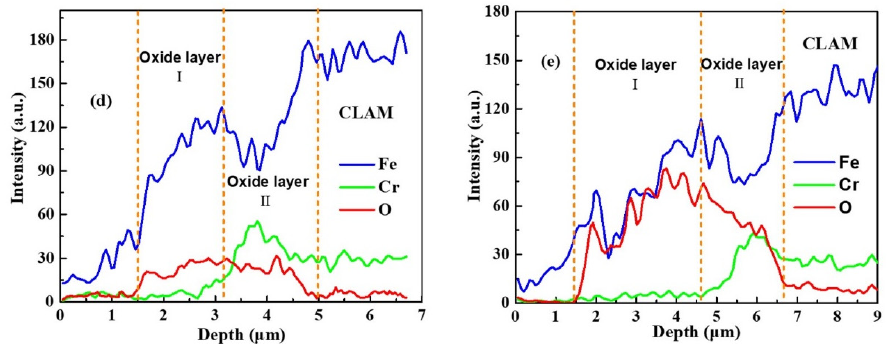
Figure 7. The elements distribution of cross-section of ( a ) 316L-1200 h, ( b ) T91-400 h, ( c ) T91-1200 h, ( d ) CLAM-400 h, and ( e ) CLAM-1200 h.